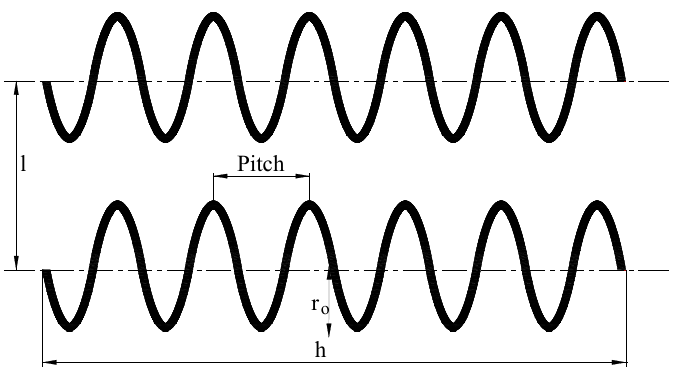
Figure 6. Design aspects of spiral coil type horizontal heat exchanger (l—pipe spacing, h—coil length, r o —coil diameter).